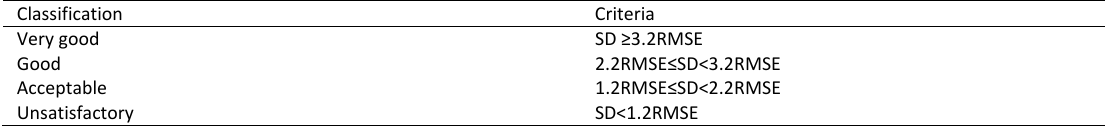
Table 2: Evaluation criteria for RMSE (Ritter and Muñoz‐Carpena, 2013)